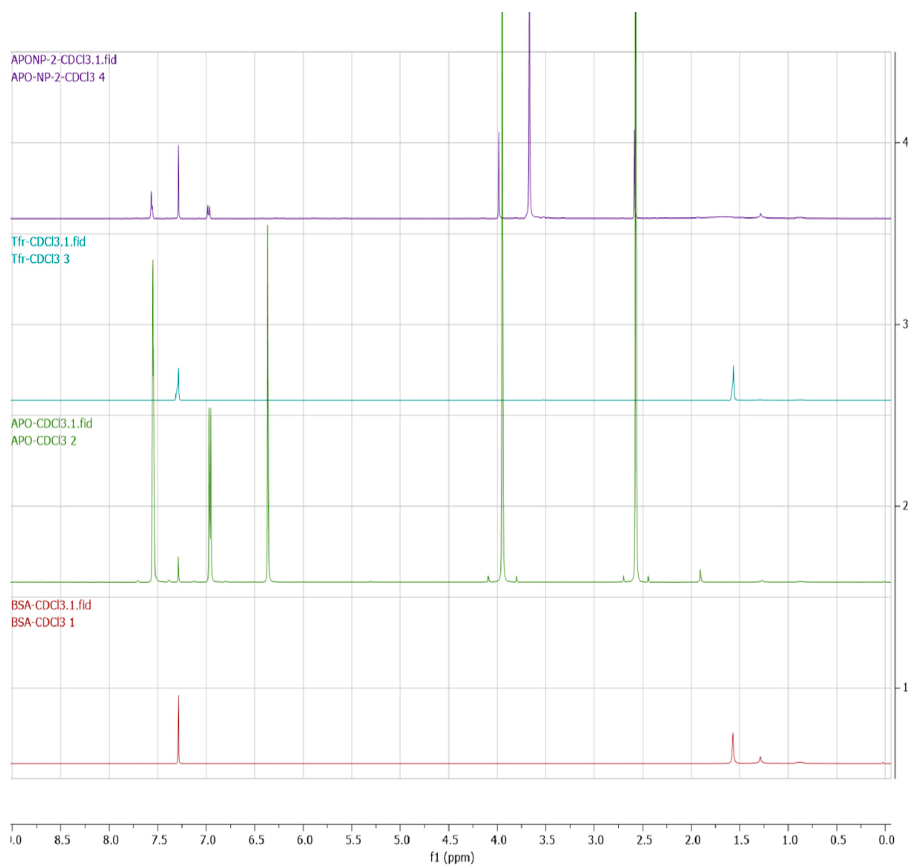
Figure 4. NMR spectra of BSA, transferrin, apocynin, and